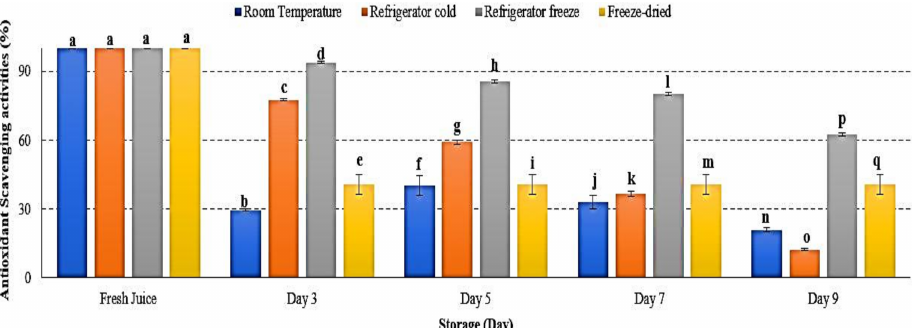
Figure 10. Antioxidant scavenging activities in watermelon juice. Different letters indicate significant differences between samples p <